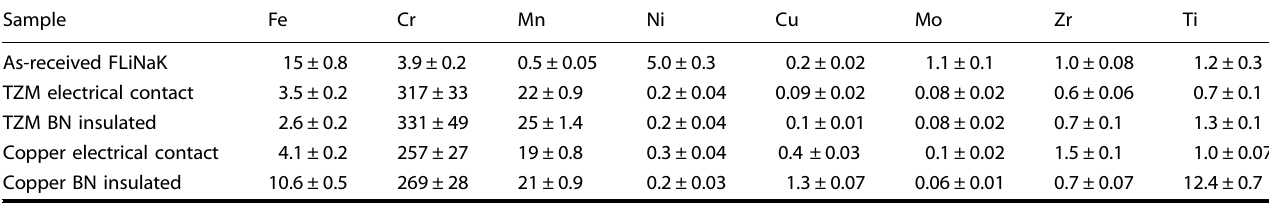
Table 1. ICP-MS results for the as-received FLiNaK and post-corrosion FLiNaK. Sample Fe Cr